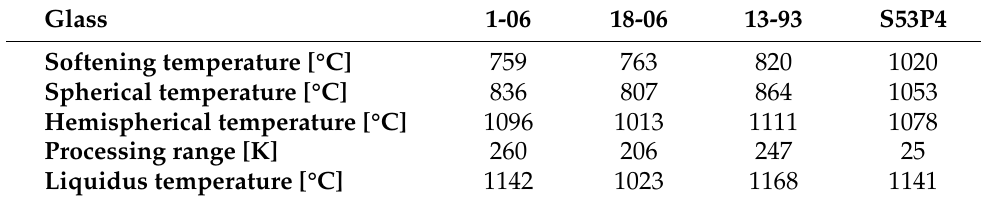
Table 6. Results from heating microscope and gradient